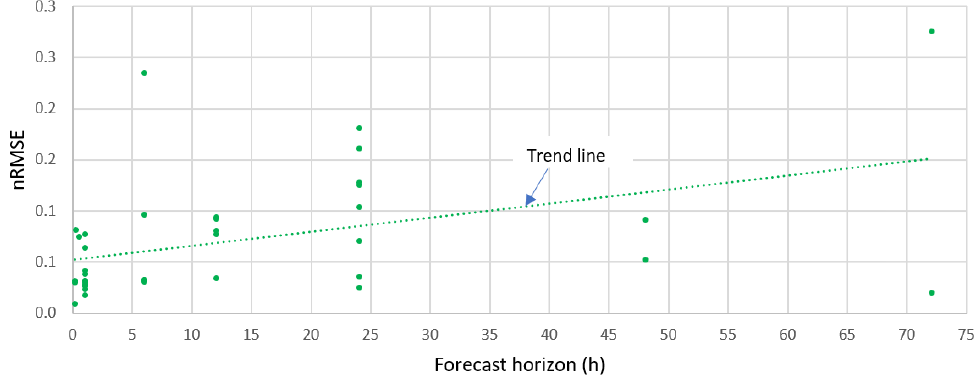
Figure 12. Dependence of nRMSE on forecasting horizon.